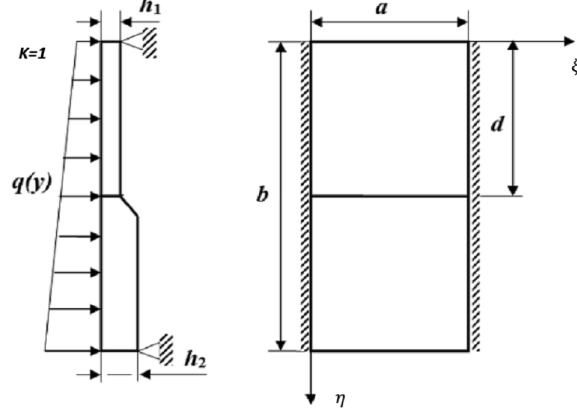
Figure 8: Rectangular plate with variable thicknesses with two opposite edges freely supported and two fixed edges [11].